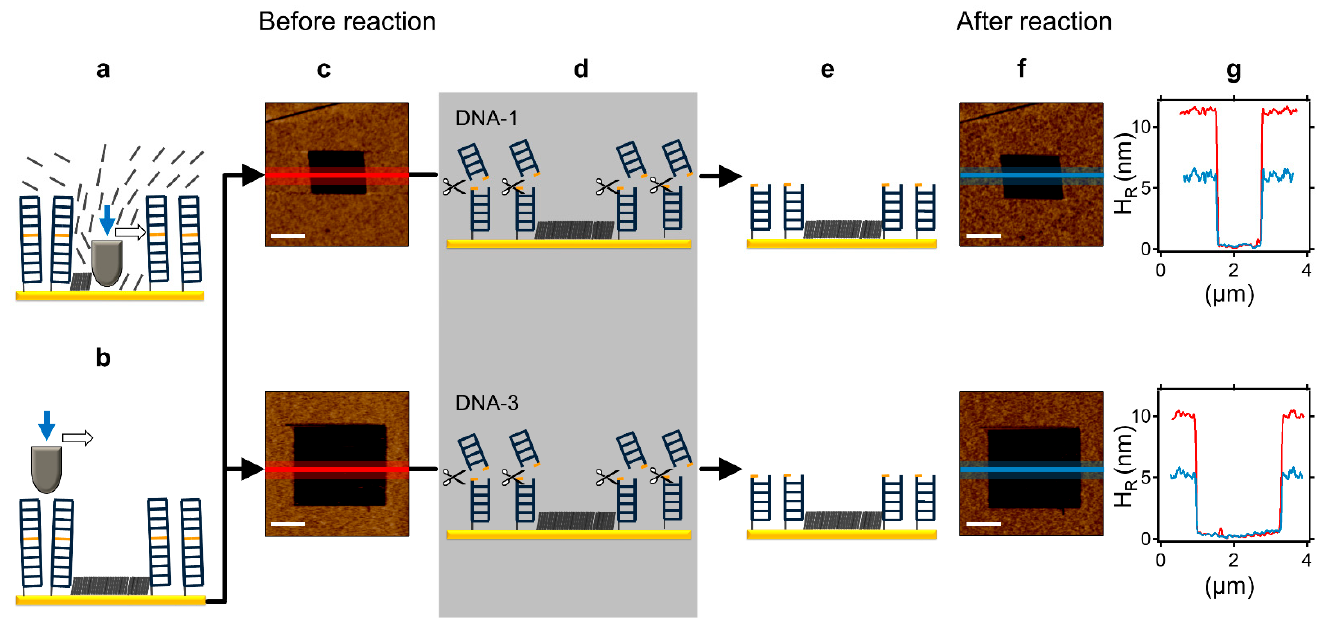
Figure 2. Noncanonical BamHI action in LCDMs exhibiting intermediate DNA density and generated by negative nanografting. ( a ) In negative nanografting, at a high applied load (~120 nN), the AFM tip displaces thiol-modified dsDNA molecules (restriction site indicated in orange) from the pre-selected area, and consequently allows immobilization of ethylene glycol-terminated alkylthiols from the contacting solution. ( b ) After washing, topographic imaging is carried out at a low applied force (~0.2 nN) to register the LCDM height before the BamHI reaction, and using the alkylthiol “pit” as an inert topographic reference. ( c ) AFM micrographs of an LCDM comprising DNA-1 (top) or DNA-3 (bottom). ( d ) Schematic representation of a complete BamHI reaction on an LCDM, creating shorter surface-bound dsDNAs ( e ) and a topographically lower LCDM. ( f ) The same AFM micrographs in ( c ) are imaged after BamHI reaction. ( g ) Average topographic line profiles of the LCDMs before (( c ), red) and after (( f ), blue) BamHI action, showing a ~50% height decrease for both DNA-1 (top) and DNA-3 (bottom). The scale bar (white) in all the AFM micrographs is 750 nm.